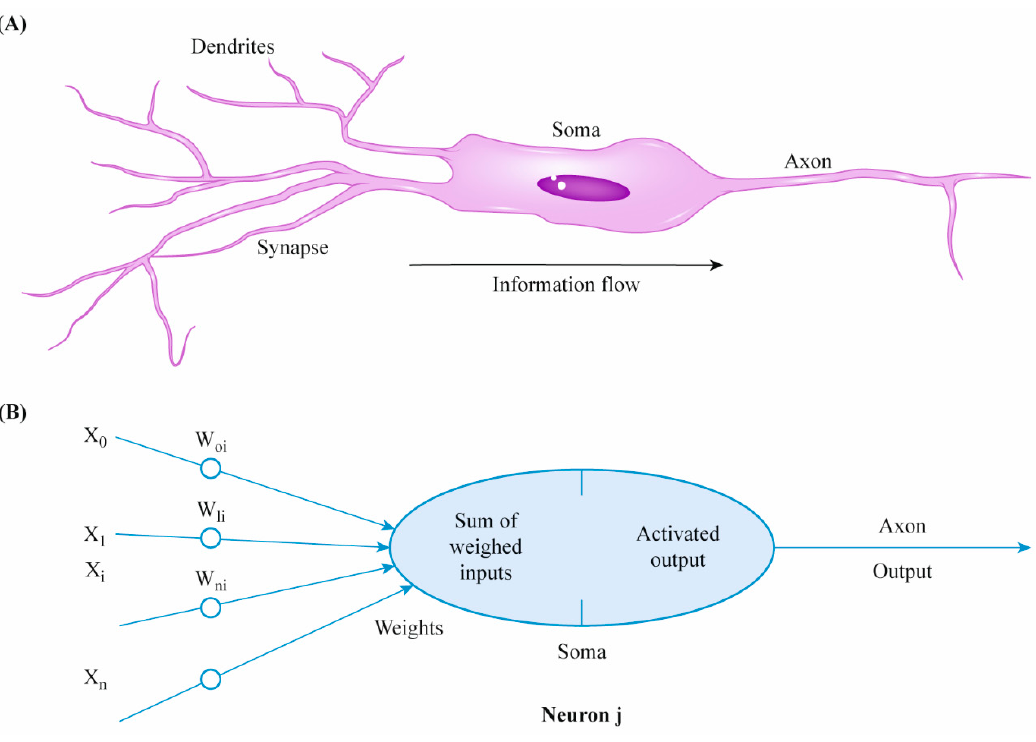
Figure 3. Schematic illustrations of information processing by ( A ) a biological neuron and ( B ) an artificial neuron. J denotes the artificial neuron index.